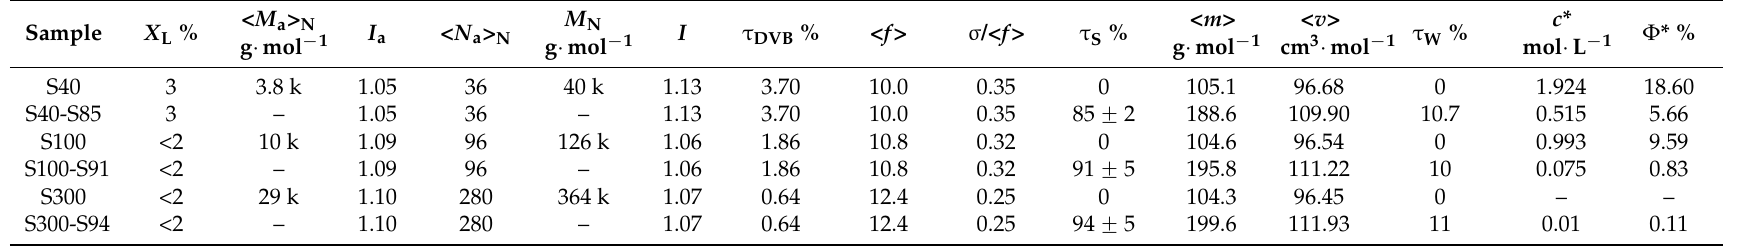
Table 1. Characteristics of the PS and NaPSS star